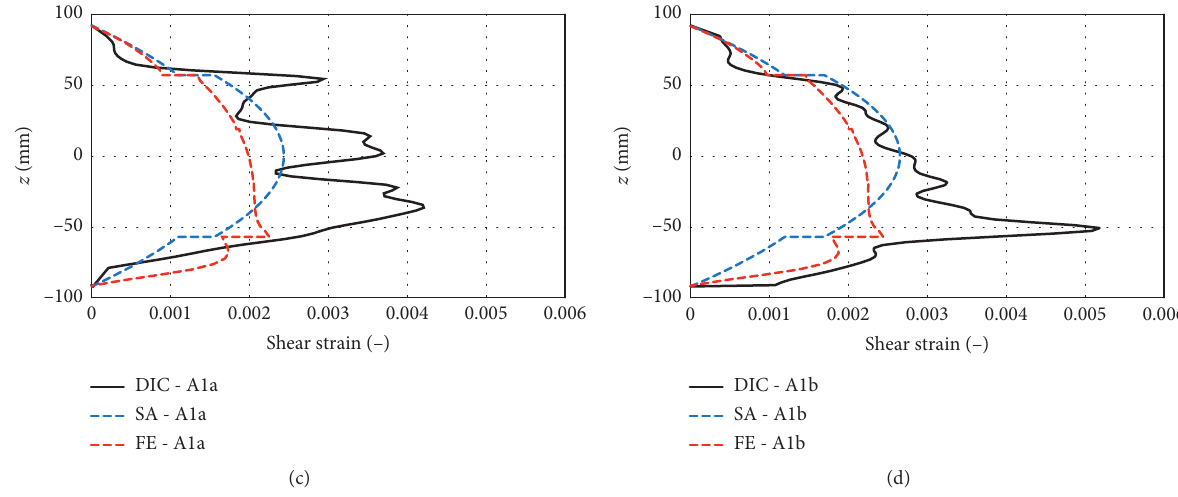
Figure 5: Colour contour plots of A1 and shear strain distribution from shear tests for A1, A1a, and A1b.